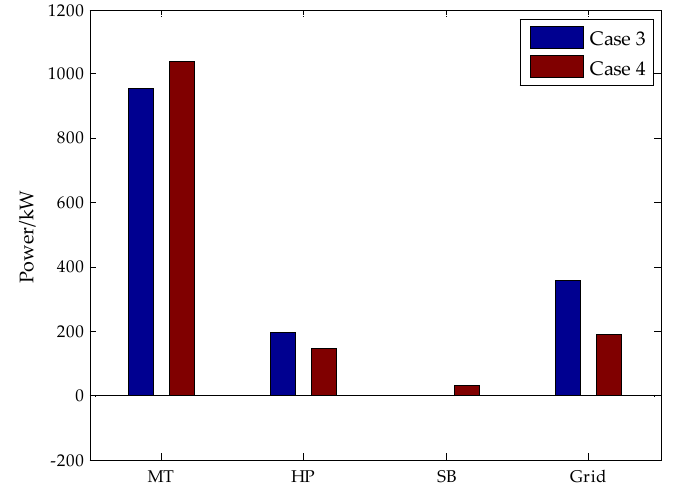
Figure 8. Changes in equipment output in winter.